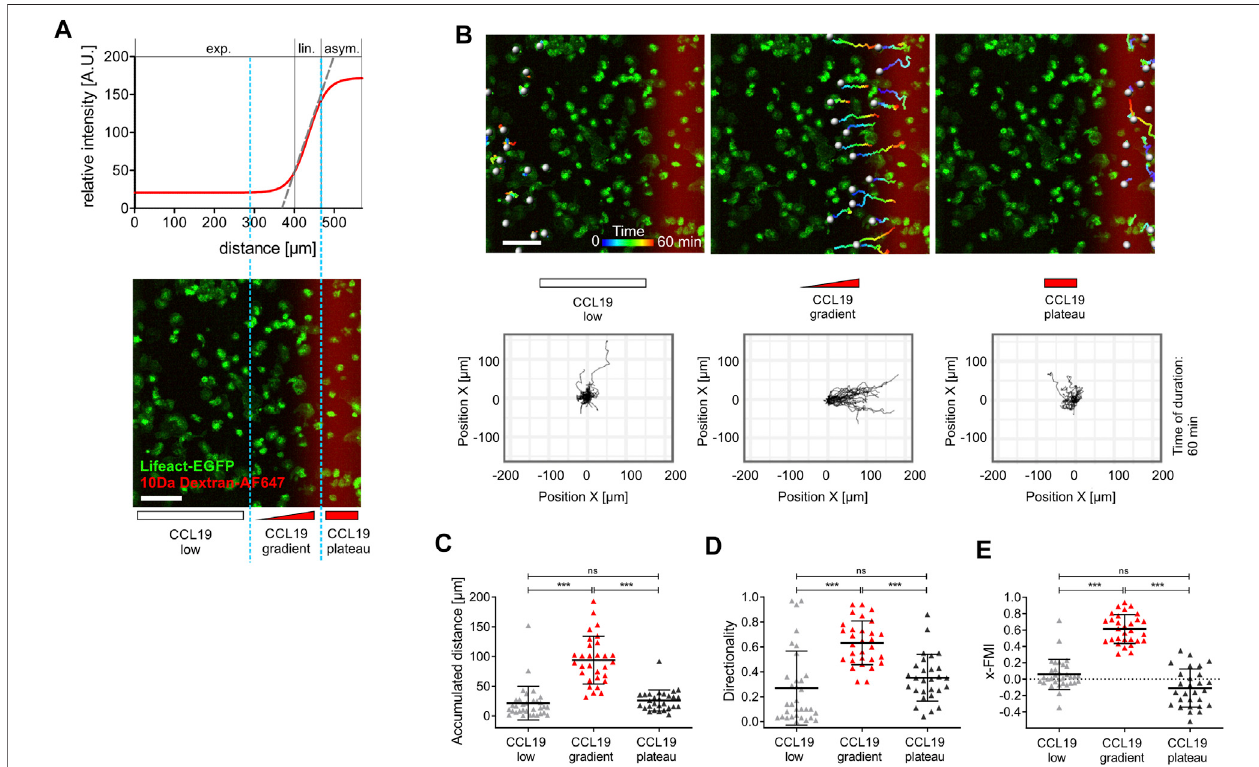
FIGURE2 | Spatial sensing and chemotactic response ofbone marrow-derived dendritic cells (BM-DCs)in stable soluble CCL19gradients. (A) Sigmoidal shaped concentration pro fi le of a stable soluble gradient analyzed with a surrogate molecule, 10 kDa Dextran Alexa Fluor (AF) 647; exp., exponential; lin., linear; asym., asymptotic.Lightbluedashed lineindicateszoninginthreeareaswithdifferentgradientsteepnessforseparatedcelltrackinganalyses: “ CCL19low, ”“ CCL19gradient, ” “ CCL19 plateau ” (upper and lower panel). Scale bar = 100 µm. (B) Pseudo-colored tracks of individual motile Lifeact-EGFP expressing BM-DCs (time is color- coded: blue = 0 min, red = 60 min) following cell tracking analysis in “ CCL19 low, ” “ CCL19 gradient, ” “ CCL19 plateau ” -areas, respectively. Green = Lifeact-EGFP expressingBM-DCs,red=10 kDaDextranAF647(upperpanel).Correspondingplotsofcelltrajectories(lowerpanel).Scalebar=100 µm.Tracksofindividualareasare representativeof fi veexperimentswith28 – 33celltracksperarea. (C – E) AnalysisofBM-DCsmigrationfor60 min,including (C) accumulateddistance, (D) directionality, (E) x-ForwardMigrationIndex(x-FMI)ofindividualcells.Representativedatafromoneof fi veexperiments;trianglesrepresentrandomlychosencellsperarea, N =28 – 33, mean ± SD. Statistical tests: (C – D) *** p ≤ 0.001, ns, non-signi fi cant, Dunn ’ s multiple comparison (post-hoc Kruskal-Wallis test). See also Supplementary Figure S1 and Supplementary Video S1 .